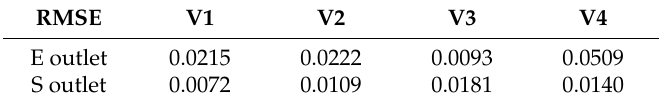
Table 4. RootMeanSquareError(RMSE)valuesforthefourscenariostoevaluatevariancesintheRTDcurves.